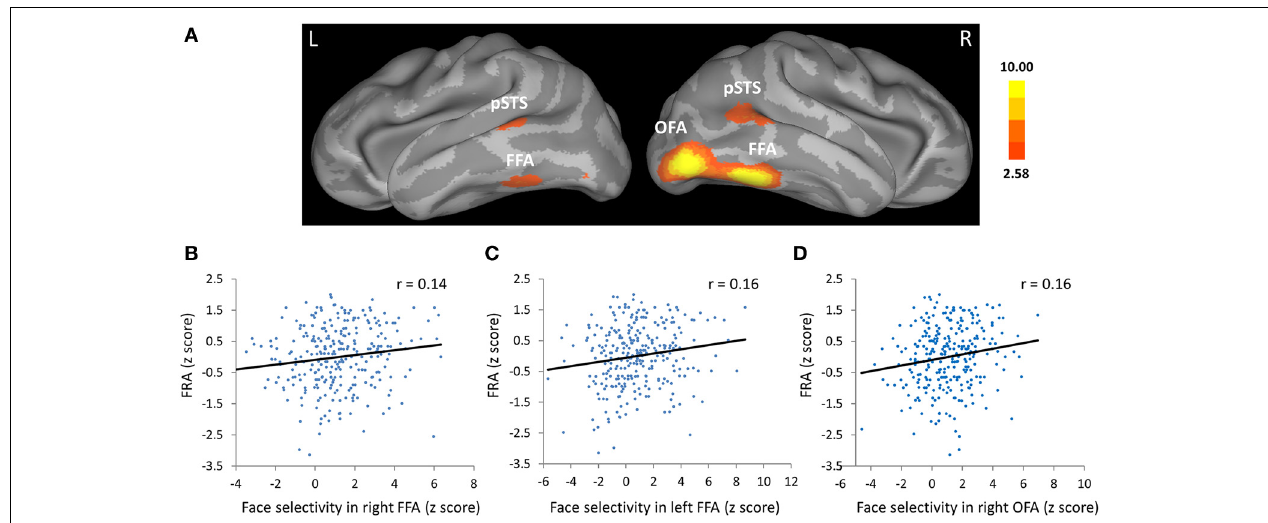
FIGURE 2 | Face selectivity in the face fusiform area (FFA) and occipital face are (OFA) was correlated with face-specific recognition ability (FRA). (A) The FFA, OFA, and the posterior part of the superior temporal sulcus (pSTS) from group-level analysisdisplayed onaninflated corticalsurface of MNI standard template for Cohort 1. Z statistic image for the contrast of faces vs. objects in group-level analysis was thresholded at Z > 2 . 58 (one